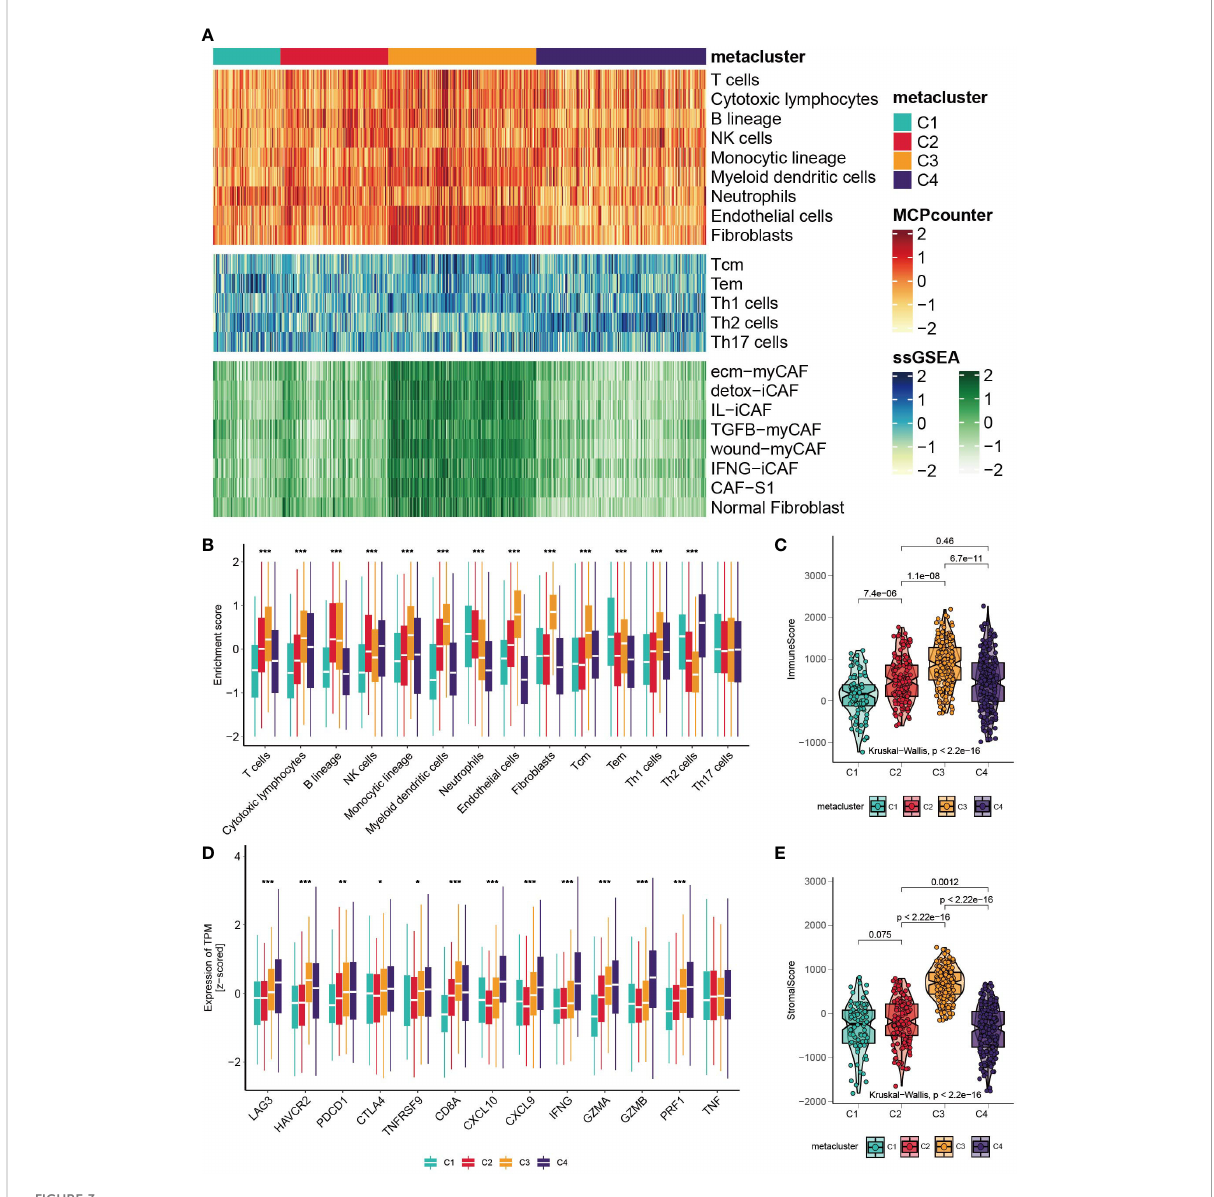
FIGURE 3 Correlation between GC subtypes and tumor in fi ltrated immune cells. (A) Heatmap of tumor in fi ltrated immune cells, T cell subtypes and fi broblast subtypes. (B) Boxplot of the enrichment level of in fi ltrated immune cells (*p < 0.05; **p < 0.01; ***p < 0.001). (C) Boxplot of the expression level of immune related genes. (D, E) Boxplot of the stromal score and immune